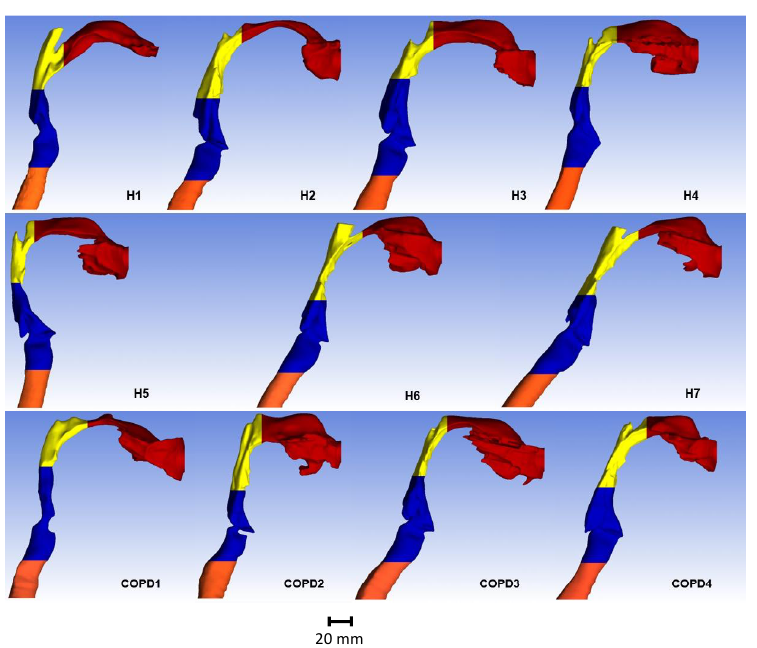
Figure A1. Upper airway geometry of all individuals. The same scale is used in all models.